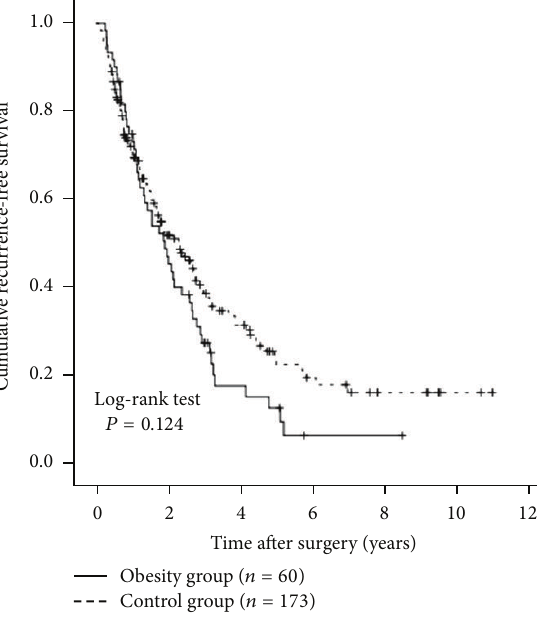
Figure 2: Cumulative overall survival (OS) rates in the obesity group ( 𝑛 = 60 ) and the control group ( 𝑛 = 173 ). The 1-, 3-, and 5- year cumulative OS rates were 98.3%, 81.0%, and 63.9%, respectively, in the obesity group and 90.0%, 70.5%, and 503%, respectively, in the control group ( 𝑃 = 0.818 ).